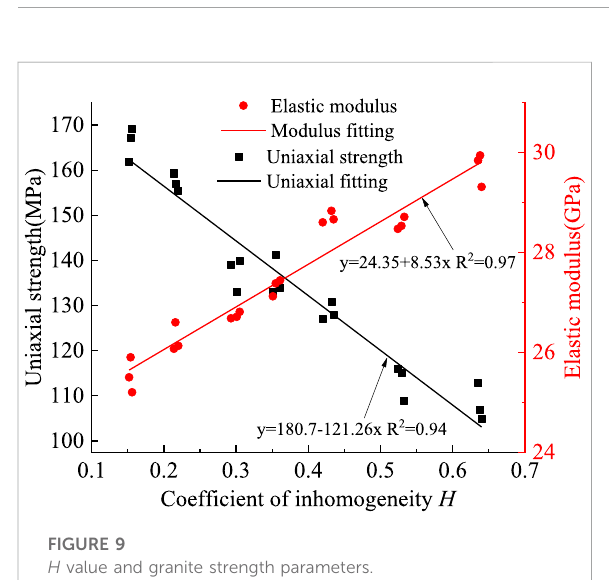
FIGURE 9 H value and granite strength parameters.